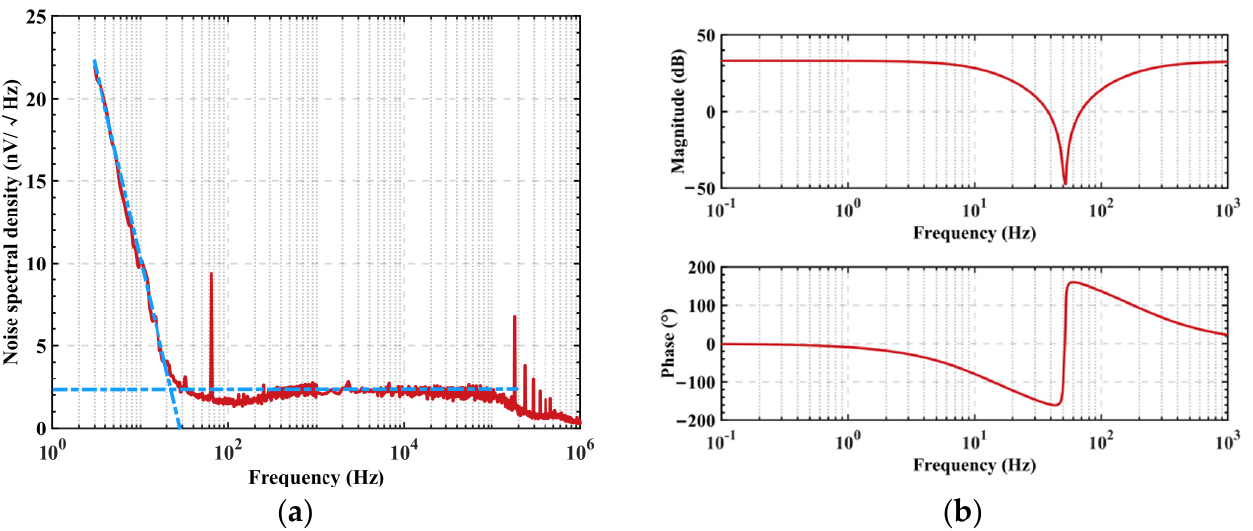
Figure 6. Circuit schematic of the electrostatic potential sensor. ( a ) Voltage noise spectral density. ( b ) Frequency response characteristic.